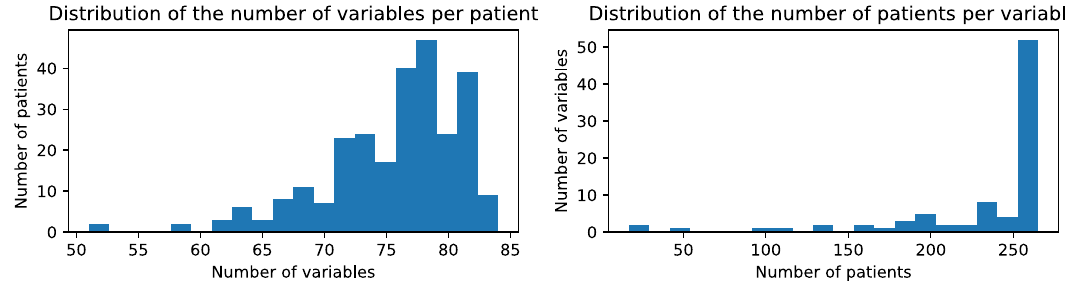
Figure 2. Clinical data and missing values. The plots show the frequency histogram for the distribution of the number of clinical variables available per patient and patients per clinical